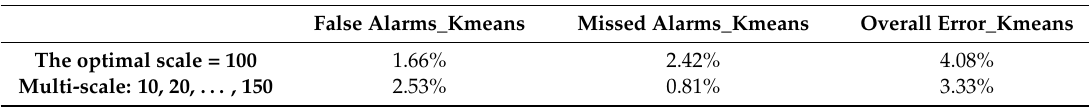
Table 3. Comparison between the change detection results of the single-scale and multi-scale proposed method, with L1 as the basis image in the first study area. Figure 5. Overall errors of change detection with different segmentation scales, with L1 as the basis False Alarms_Kmeans Missed Alarms_Kmeans Overall image in the first study area.